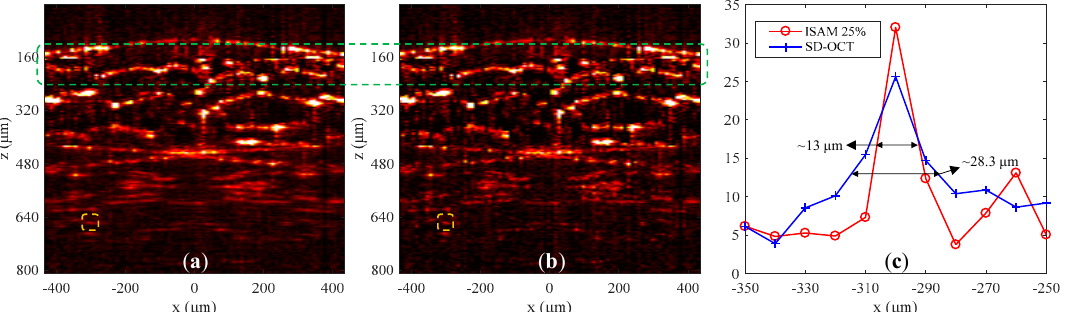
Figure 6. Experiment results of the onion. The images in ( a ) and ( b ) are results of SD-OCT (100% data) and CS-ISAM (25% data), respectively. ( c ) Lateral distribution of the structures within the yellow dashed boxes in ( a ) and ( b ).